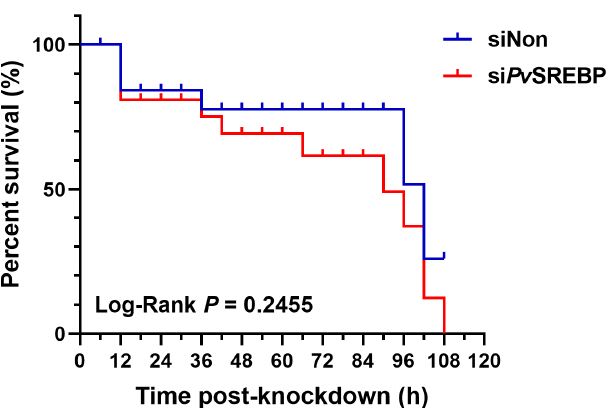
Figure 7. Shrimp ( P. vannamei ) survival curve after Pv SREBP knockdown. Shrimp survival ( n = 30 per group) was determined after intramuscular injection with siNon (scrambled siRNA) si P vSREBP and the number of shrimps recorded at 6 h intervals. The product-limit method of Kaplan-Meier was used to calculate the shrimp survival rate and the significance compared using the log-rank test.